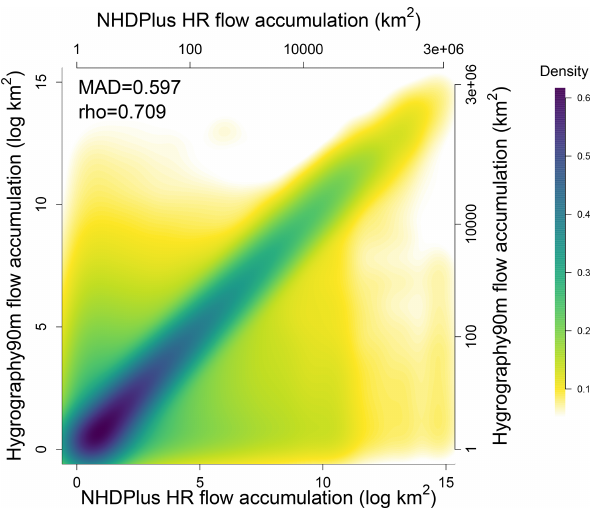
Figure 10. Density plot of Hydrography90m vs. NHDPlus HR flow accumulation (log-scale) of those 28 million stream channel grid cells with a flow accumulation larger than 1km 2 . Median absolute deviation (MAD) and Spearman coefficient (rho) were computed using all 61 million stream channel grid cells. The colour bar indi- cates a 2D kernel density estimate. Table 2. The surface area of the 10 largest drainage basins worldwide in km 2 , compared among the Hydrogryphy90m, Hy- droBASINS (Lehner and Grill, 2013), and Hydro1k (USGS EROS Archive, 2018)